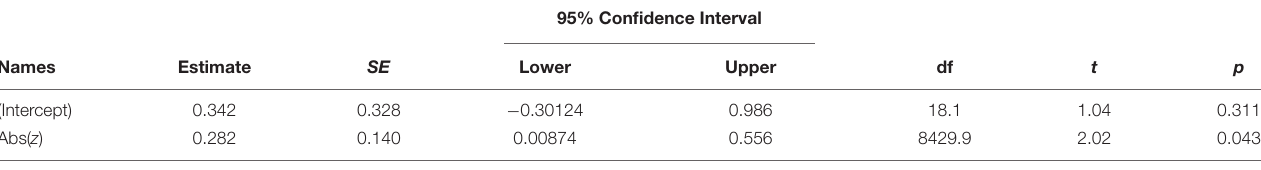
TABLE 1 | Fixed effects parameter estimates for model using reference set.